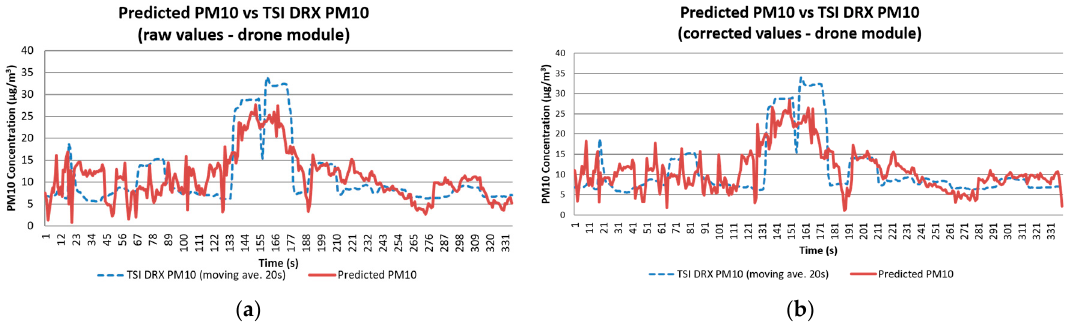
Figure 17. Comparison between PM 10 concentration readings obtained with the TSI DRX and the predicted values calculated for Test 2 using the models generated with ( a ) raw values, and ( b ) corrected data.